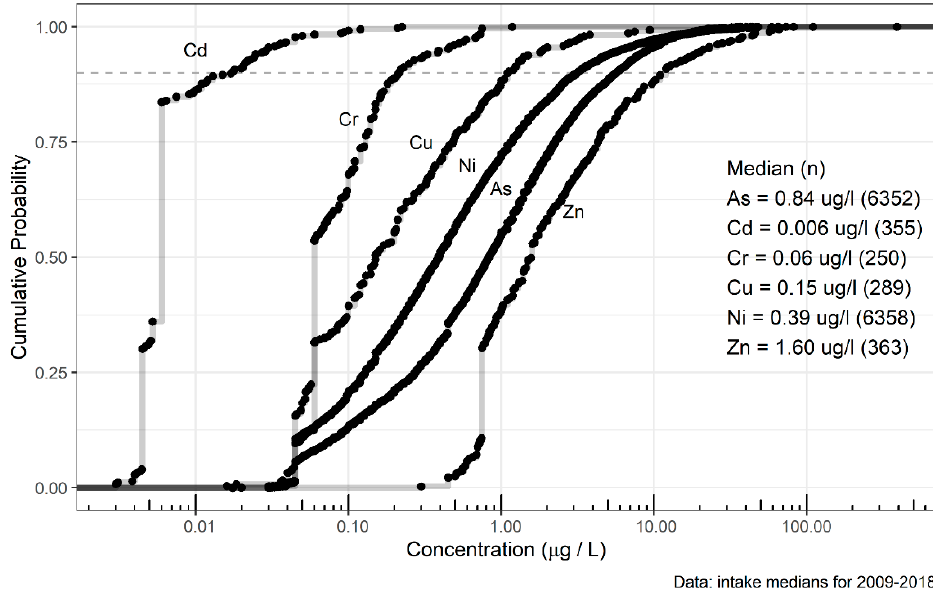
Figure 3. Empirical distribution for As, Cd, Cr, Cu, Ni, and Zn in Danish groundwater at waterworks wells used for drinking water production; each point is a median concentration for 2009–2018 at each sampling point.